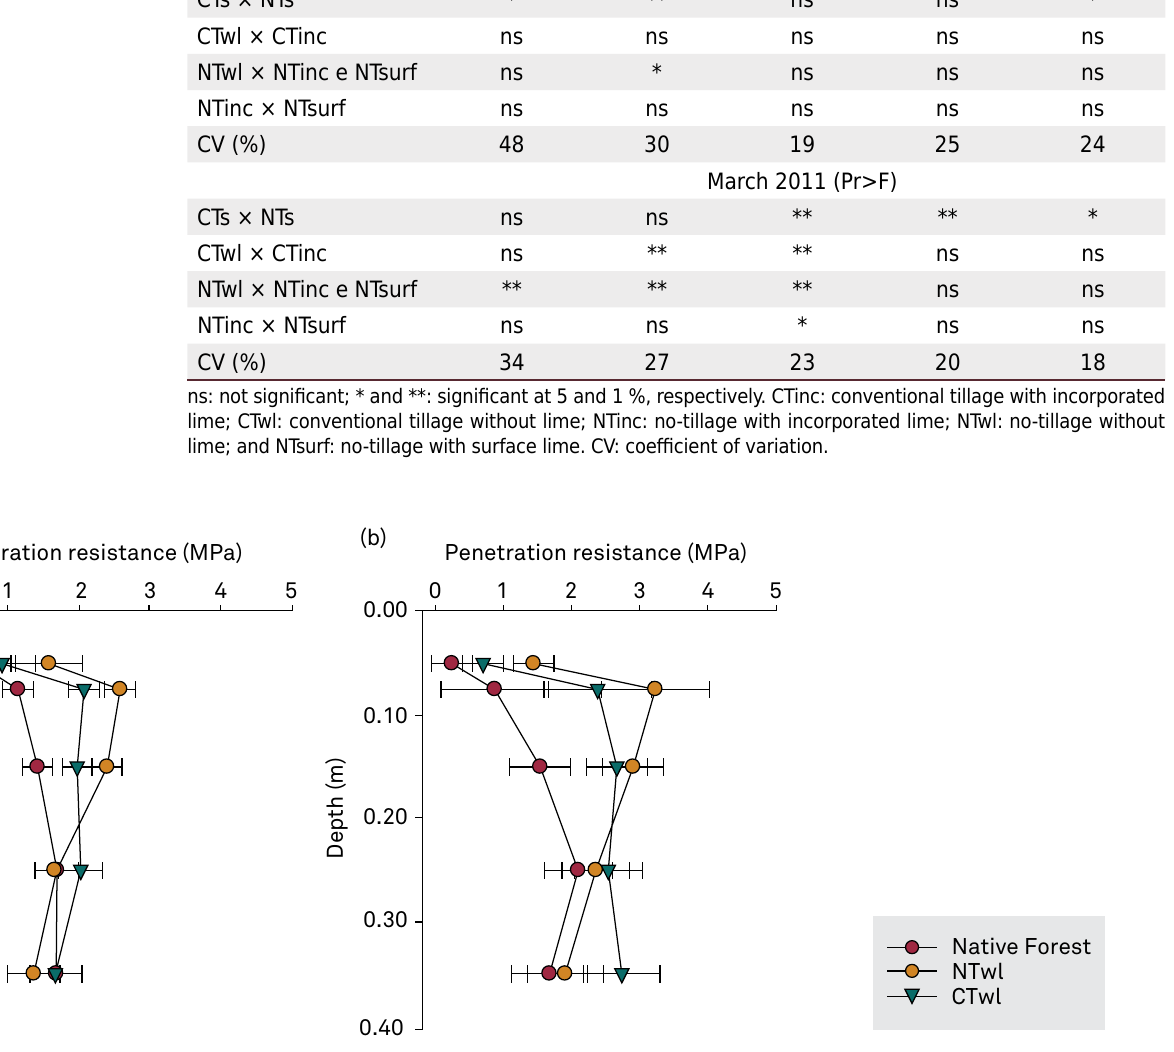
Figure 5. Penetration resistance in a Latossolo Bruno Alumínico típico (Hapludox) under different soil use and tillage systems in May 2009 (a) and March 2011 (b) after more than 30 years of the tillage system adopted. Horizontal bars indicate the interval of least significant difference for the t test and the overlapping of them in the same soil layer indicates the absence of differences between the averages of the systems. CTwl: Conventional tillage without lime; and NTwl: No-tillage without lime.